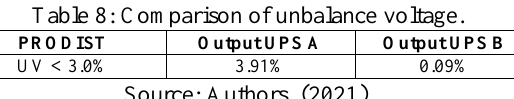
Table 8: Comparison of unbalance voltage. PRODIST